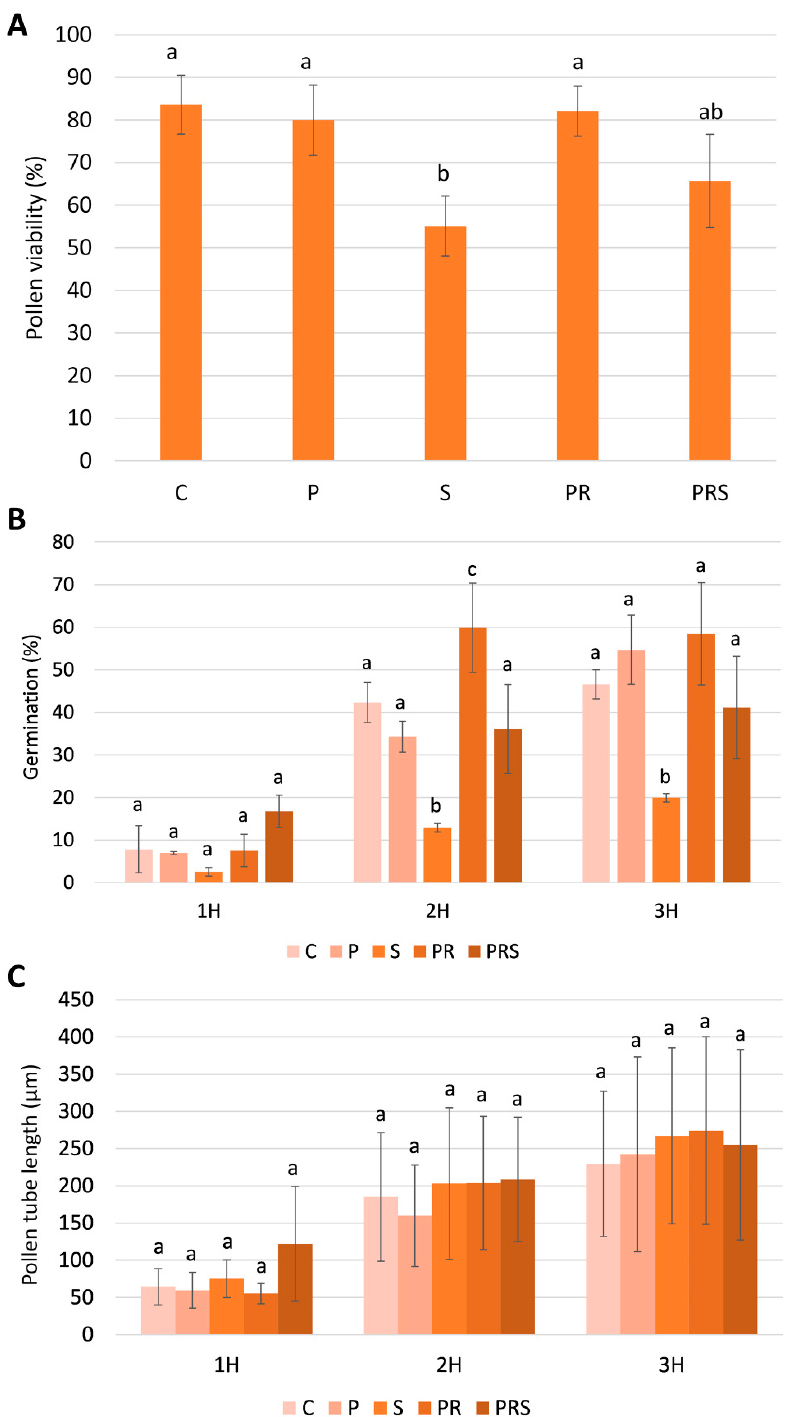
Figure 1. Analysis of pollen physiological parameters: ( A ) pollen viability; ( B ) pollen germination and ( C ) pollen tube length in control sample (C); primed sample (P); stressed sample (S); primed and recovered sample (PR); primed, recovered and stressed sample (PRS). For each treatment at least 100 pollen grains were considered, and results are expressed as averages ± standard deviation of three experiments analyzed in triplicate. Averages were compared by one-way ANOVA (for pollen germination and pollen tube growth means were compared within 1 h, 2 h and 3 h). Bars marked with the same letter are not significantly different ( p ≥ 0.05).